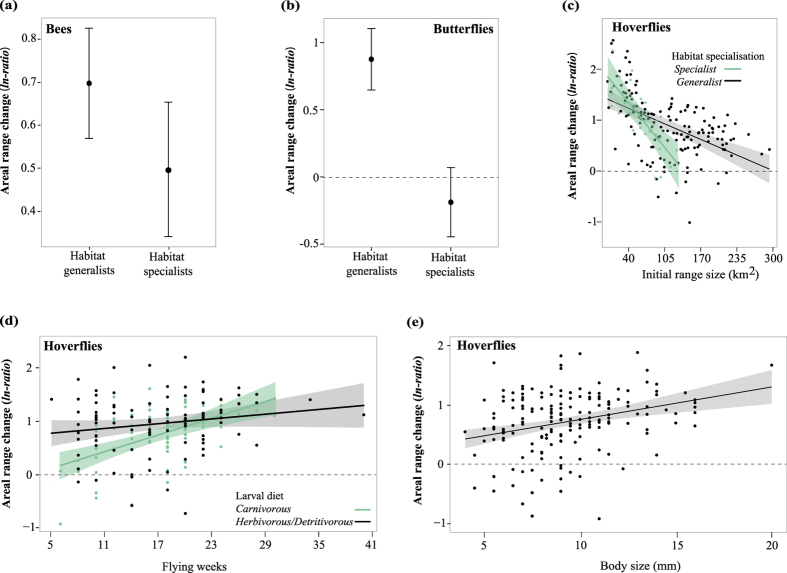
Areal range changes of pollinators (bees, butterflies, hoverflies) explained by species traits.(a) Bee habitat generalists show on average greater areal range expansions than specialists. (b) Butterfly habitat generalists show range expansions whereas habitat specialists show contractions. (c) Areal range expansions of hoverflies are similar in magnitude for both habitat generalists and specialists. The effect of habitat specialisation is dependent on the species initial range size. (d) Hoverfly’s areal range changes depend on larval food and flight period length. Areal range changes of hoverflies with larvae feeding on animals increase more strongly with flight period length than those of species with larvae feeding on other resources. (e) Effect of body size on areal range changes of hoverflies. Large-bodied species increase range size more strongly than small-bodied species. For all plots the average prediction ±95% confidence intervals are shown. For statistical details see Supplementary Table S3.